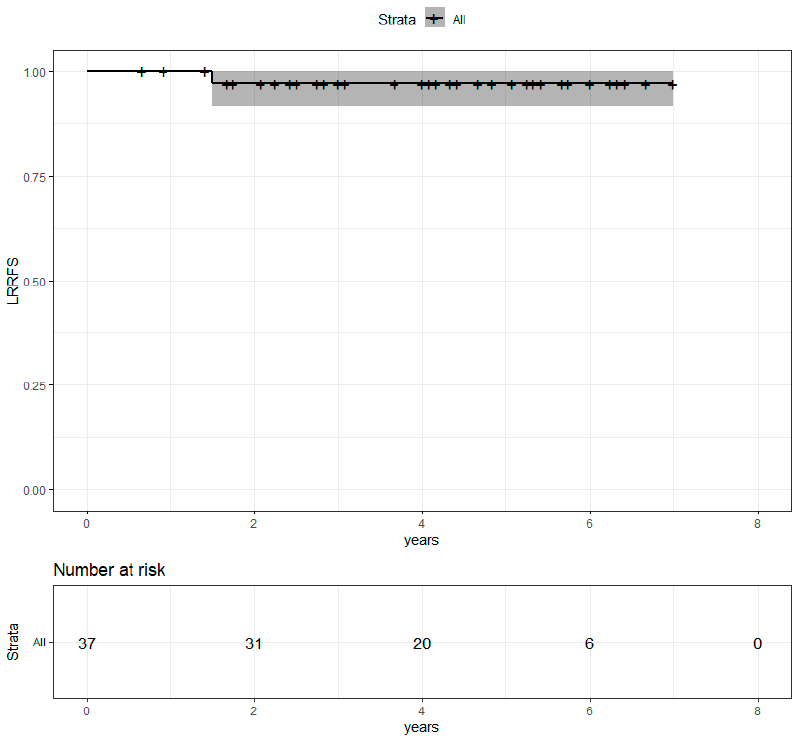
Figure 3. Progression-free survival of the population with metastatic disease at the time of diagnosis after concomitant RT and Pertu/Trastu dual HER2 blockade. Confidence intervals are provided in grey.